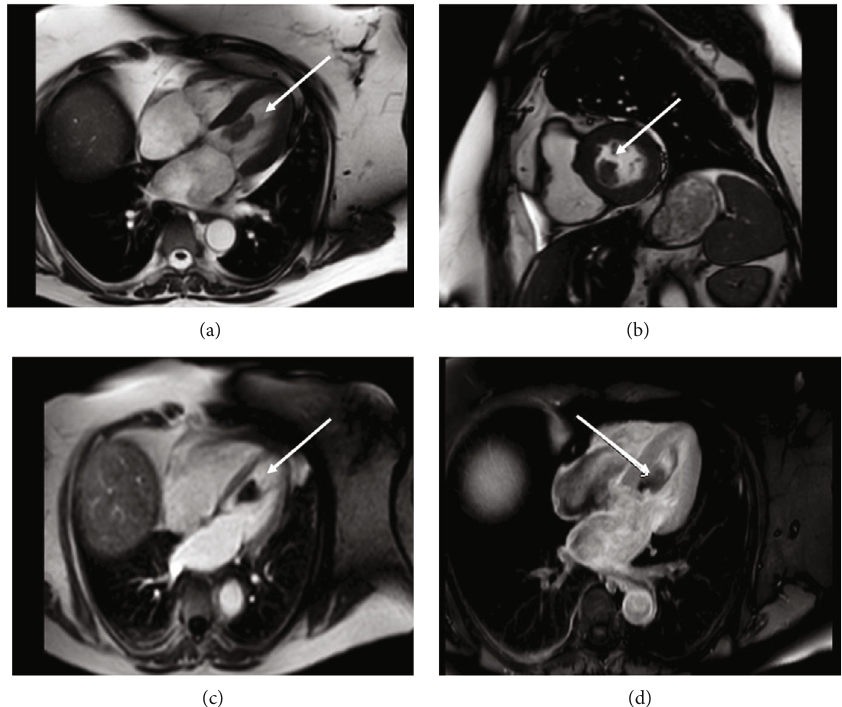
Figure 3: Cardiac MRI. Panels (a), (b), (c), and (d) show in di ff erent sequences a mass attached to the mitral valve apparatus and interventricular septum.